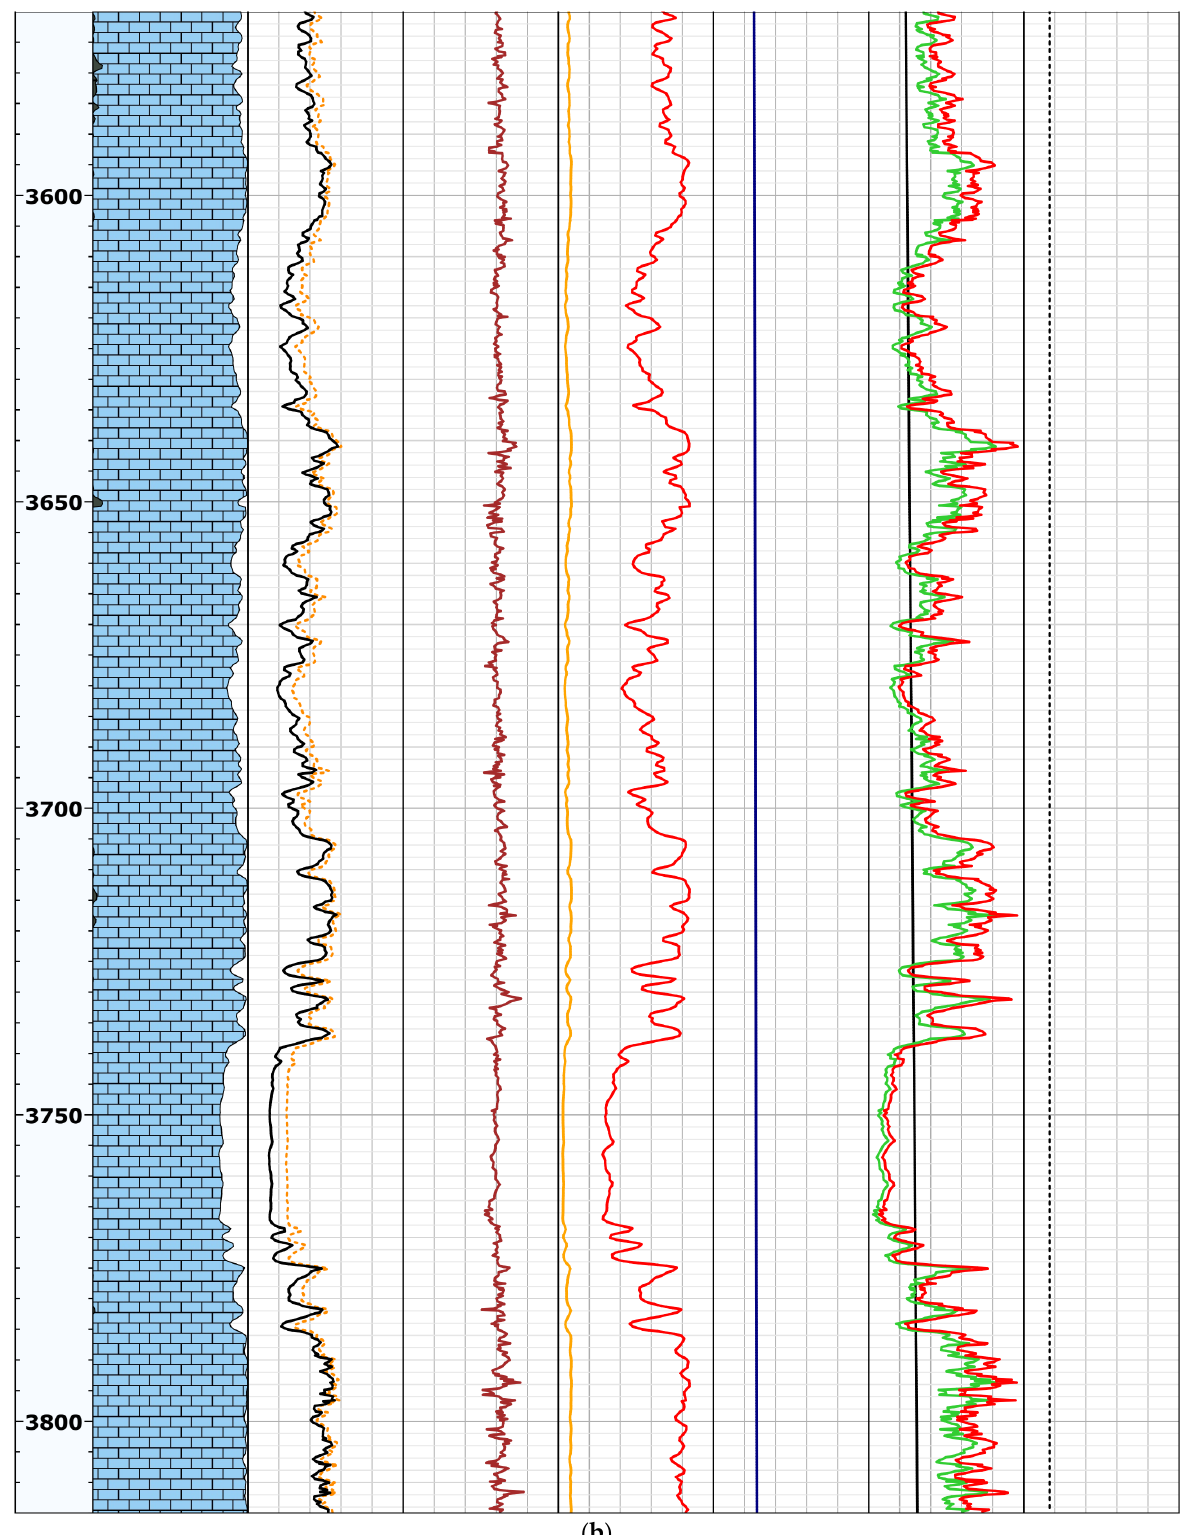
Figure 5. ( a ) Mechanical Earth Modeling results for depth interval of 3370–3570 m (11,057 to 11,713 ft). ( b ) Mechanical Earth Modeling results for depth interval of 3570–3815 m (11,713 to 12,517 ft).